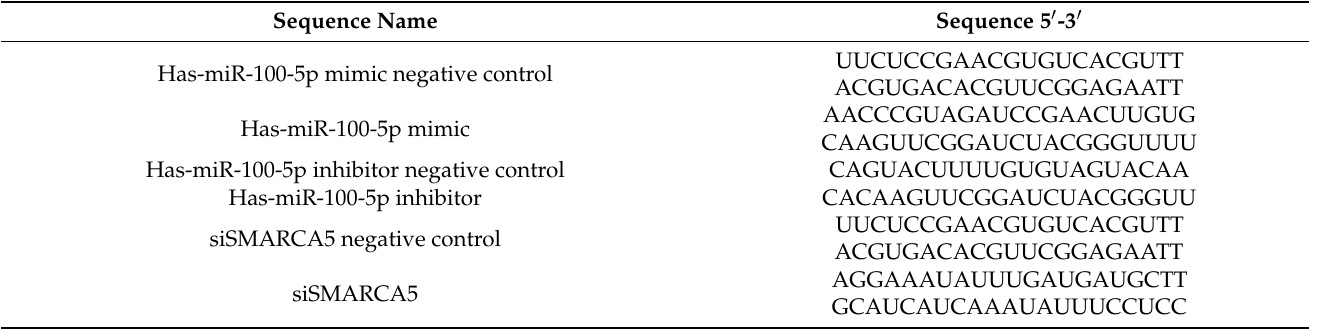
Table 1. RNA oligonucleotides